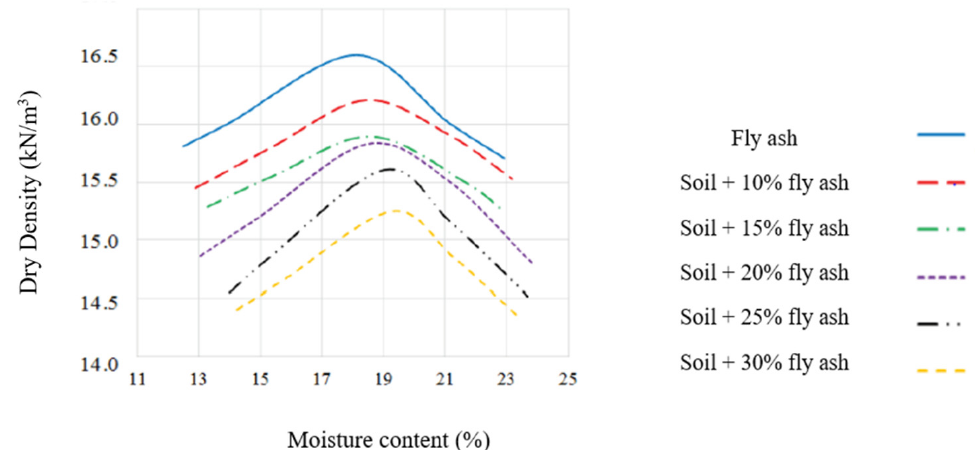
Figure 4. Compaction curves for the specimen stabilized with fly ash class C.